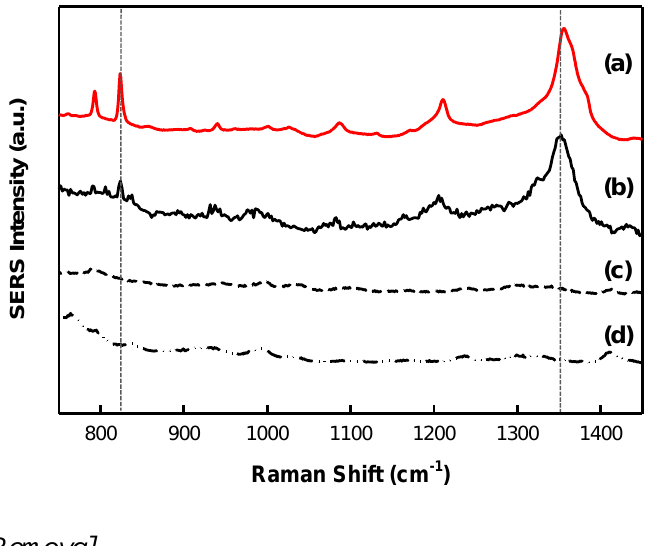
Figure 5. SERS spectra recorded for (a) free template TNT, (b) TNT-doped xerogel film (MIP), (c) control A, and (d) control B. Spectra are offset for clarity. The vertical dashed lines indicate the peaks related to TNT, which are not evident in the control spectra.